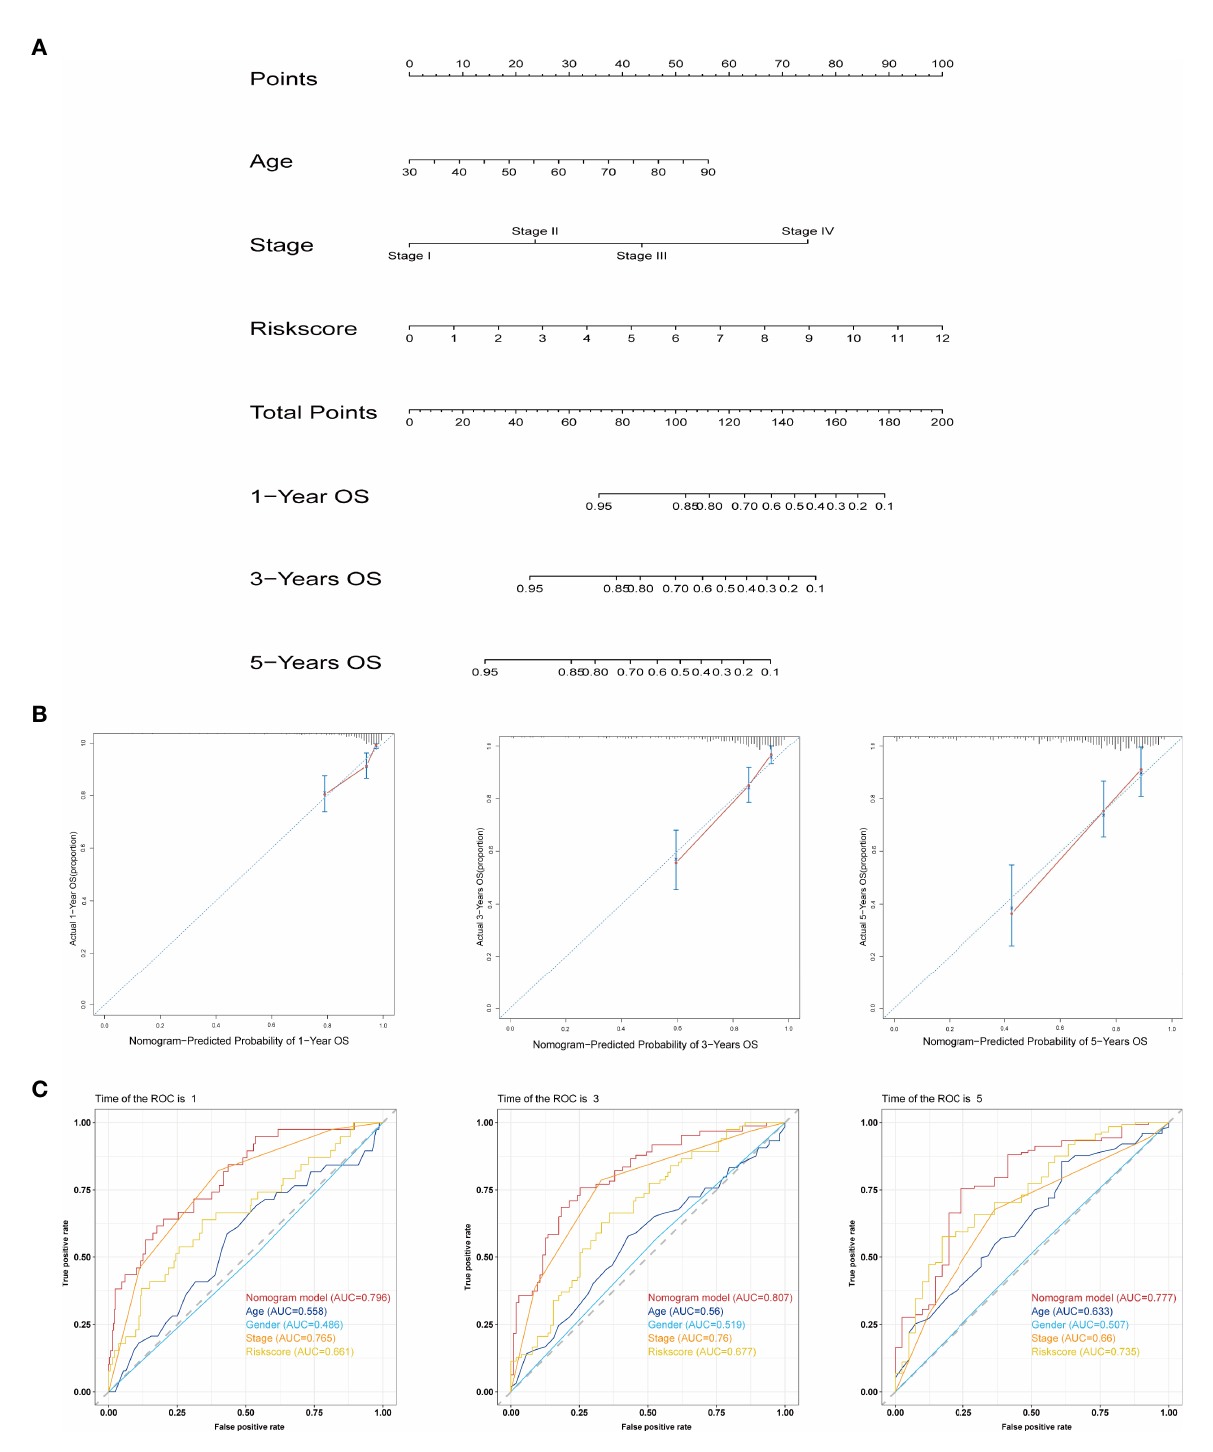
FIGURE 5 | Establishment and assessment of the prognostic nomogram based on the IFN- g -related lncRNA signature and clinicopathological features. (A) Nomogram for predicting the 1-, 3-, and 5-year prognosis of COAD patients. (B) Calibration curves of the nomogram for predicting the probability of OS at 1, 3, and 5 years. The X-axis represents nomogram predicted survival and the Y-axis represents the actual survival. (C) ROC curves of the nomogram for predicting OS at 1, 3, and 5